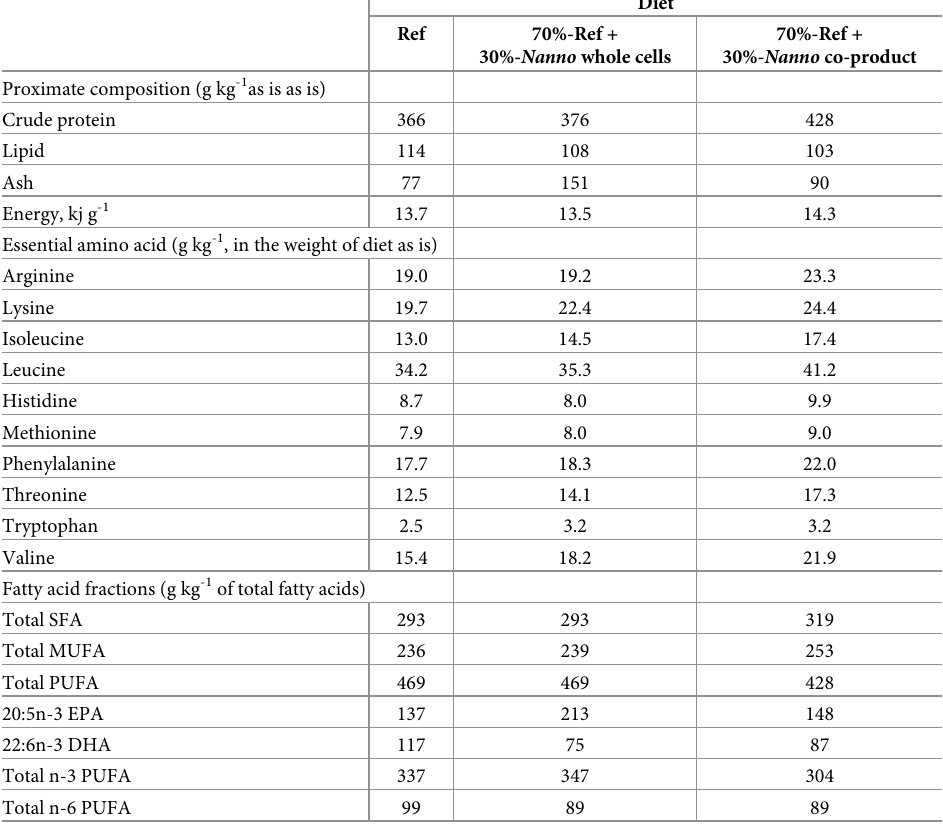
Diet Ref 70%-Ref + 70%-Ref + 30%- Nanno whole cells 30%- Nanno co-product